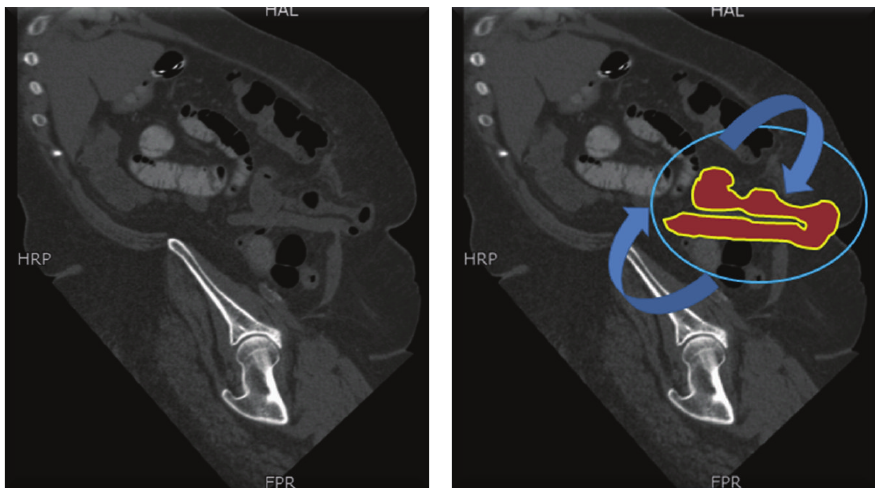
Figure3:CTscansina54-year-oldwomanwithatwo-monthhistoryofnauseaandvomitingacutelypresentingwithworseningofsymptoms. (a) Axial and coronal CT images obtained with intravenous contrast agent show herniated loops of small-bowel loops through a defect in anterior abdominal wall; however, the tract of bowel could not be completely elucidated on axial and coronal sections alone (yellow circles). (b) Oblique reformation exactly shows the outgoing and incoming loops of bowel with proximal dilated segments of bowel representing partial obstruction (blue circles and curved